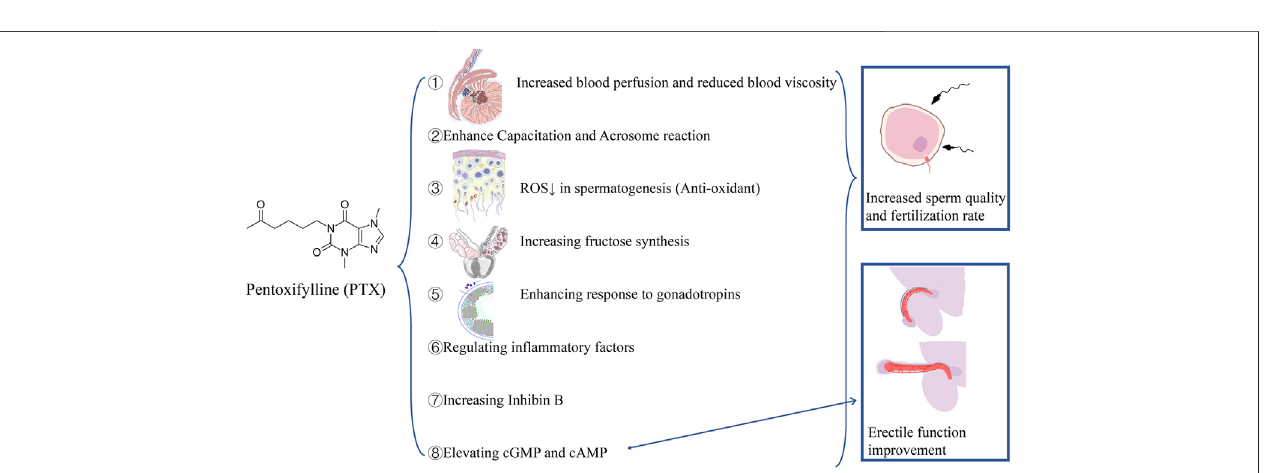
FIGURE 3 | Mechanisms of oral PTX in the treatment of poor sperm quality and erectile dysfunction.